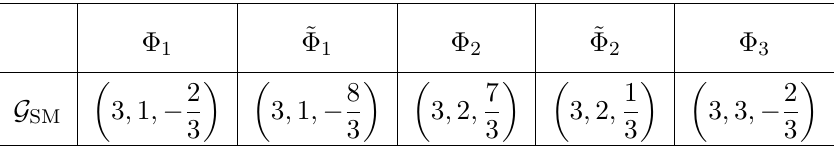
Table 1. LQ representations under the SM gauge